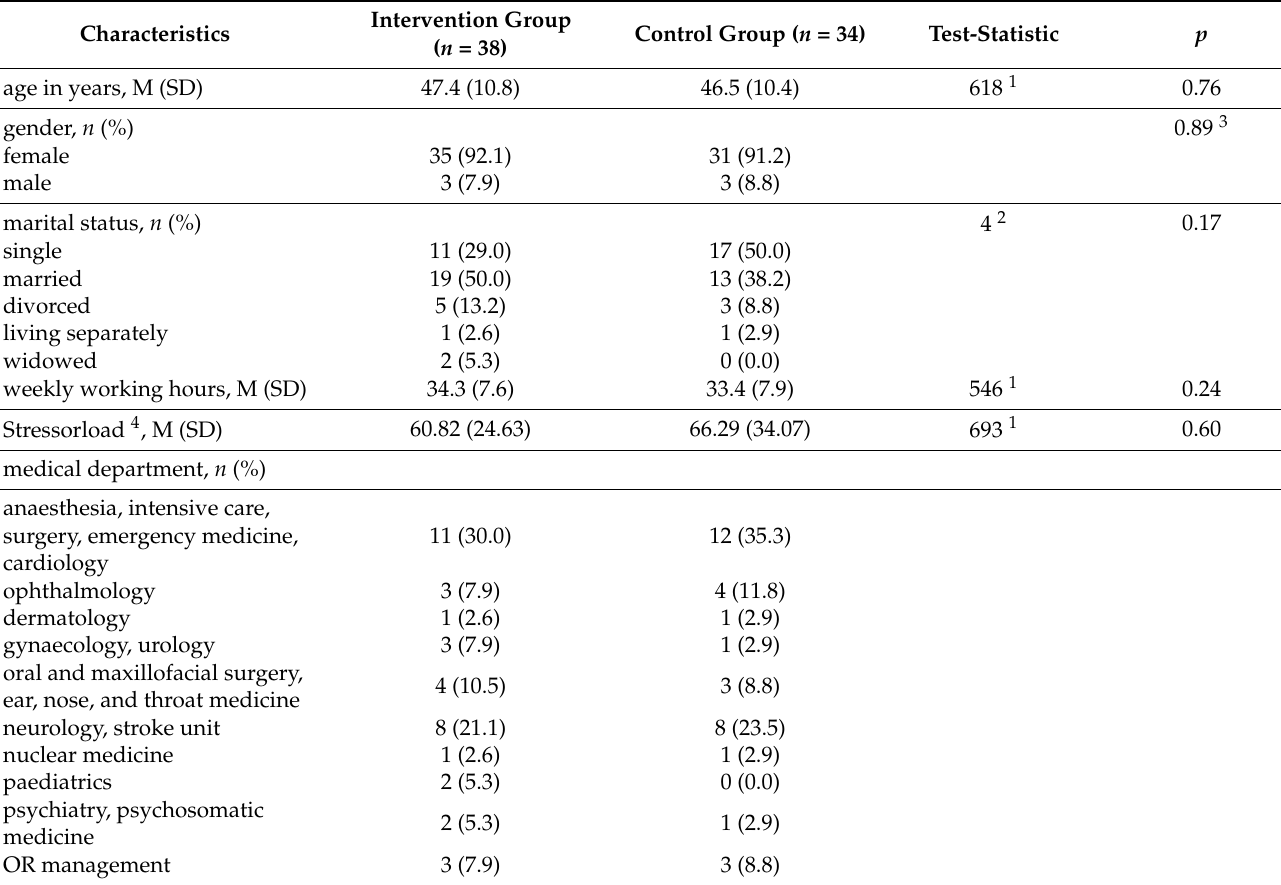
Table 1. Socio-demographic characteristics of the sample at baseline, t0 (N = 72)